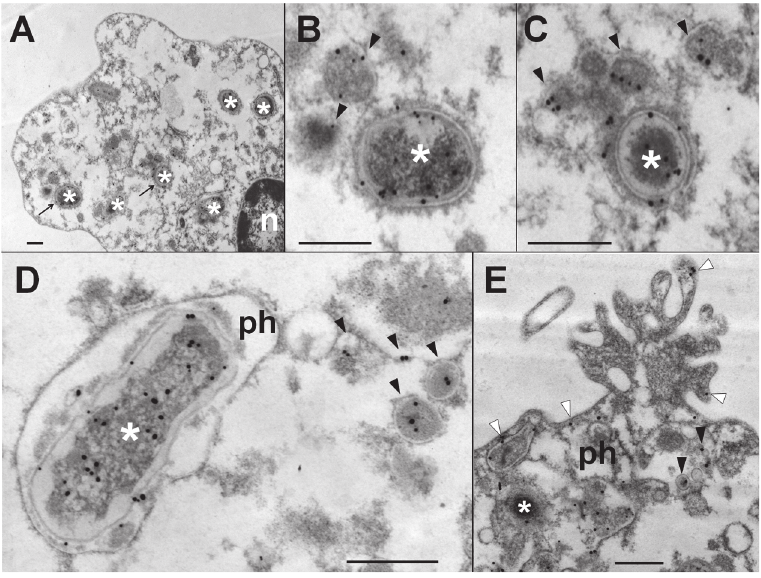
Fig 5. Br- LPS released inside cells is mostly found within vacuolar compartments of PMNs. Purified human PMNs 5 ×10 6 were infected with B . abortus 2308 at MOI 20. After one hour incubation, infected cells were fixed and processed for immunogold staining and electron microscopy. Detection of Br -LPS was performed using mouse IgG anti Br-LPS in combination with protein-A/protein-G colloidal gold 15 nm. (A) PMN (n, nucleus of cell) with intracellular B . abortus (white asterisk) and immunogold detection of Br -LPS. (B) and (C) correspond to amplified sections pointed with arrows from “ A ” panel; B . abortus (white asterisk) and immunogold detection of Br -LPS inside vacuoles (pointed by black arrow heads). (D) B . abortus (white asterisk) within a phagosome (ph) and vacuoles containing immunogold labeled Br -LPS (black arrow heads). (E) PMN membrane ruffle showing immunogold detection of Br -LPS associated to the membrane (white arrow heads) and B . abortus (white asterisk) debris inside a phagosome (ph) and immunogold detection of Br -LPS inside vacuoles (black arrow heads). No colloidal gold particles were observed when IgG purified from normal mouse serum was used for controlling the specificity of the reaction. Bar represents 500